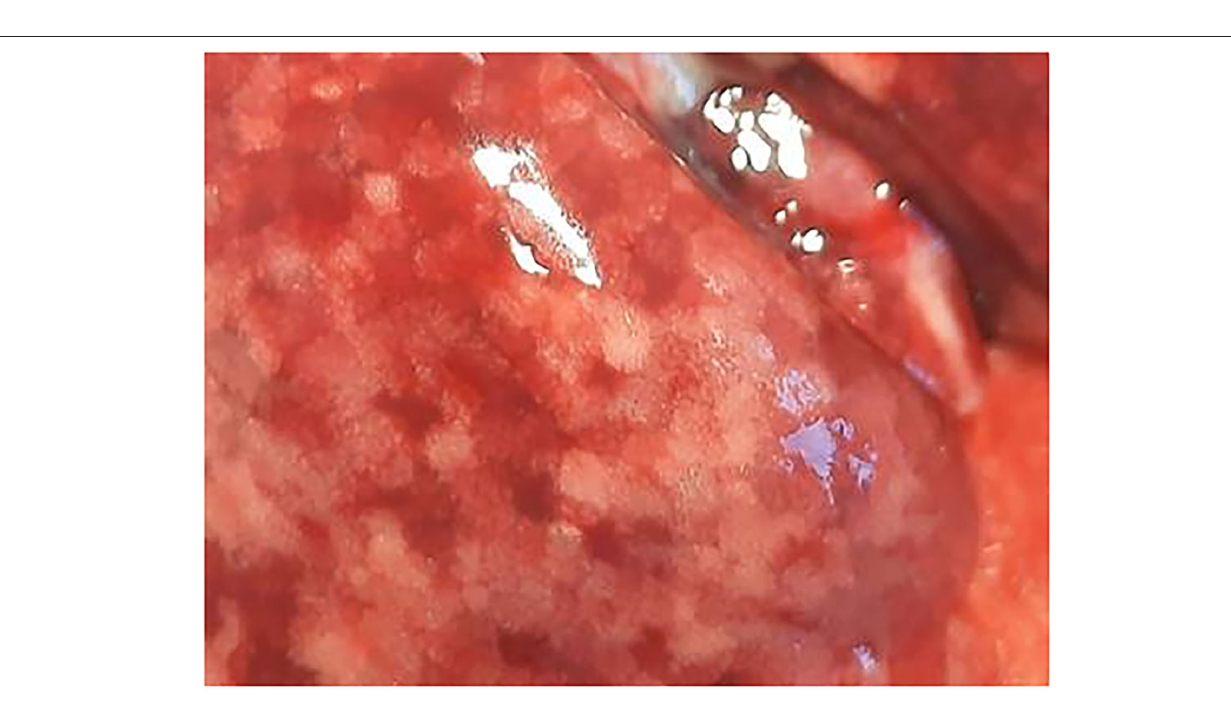
at 22 + 2 ◦ C for temperature and 55 + 15% for relative